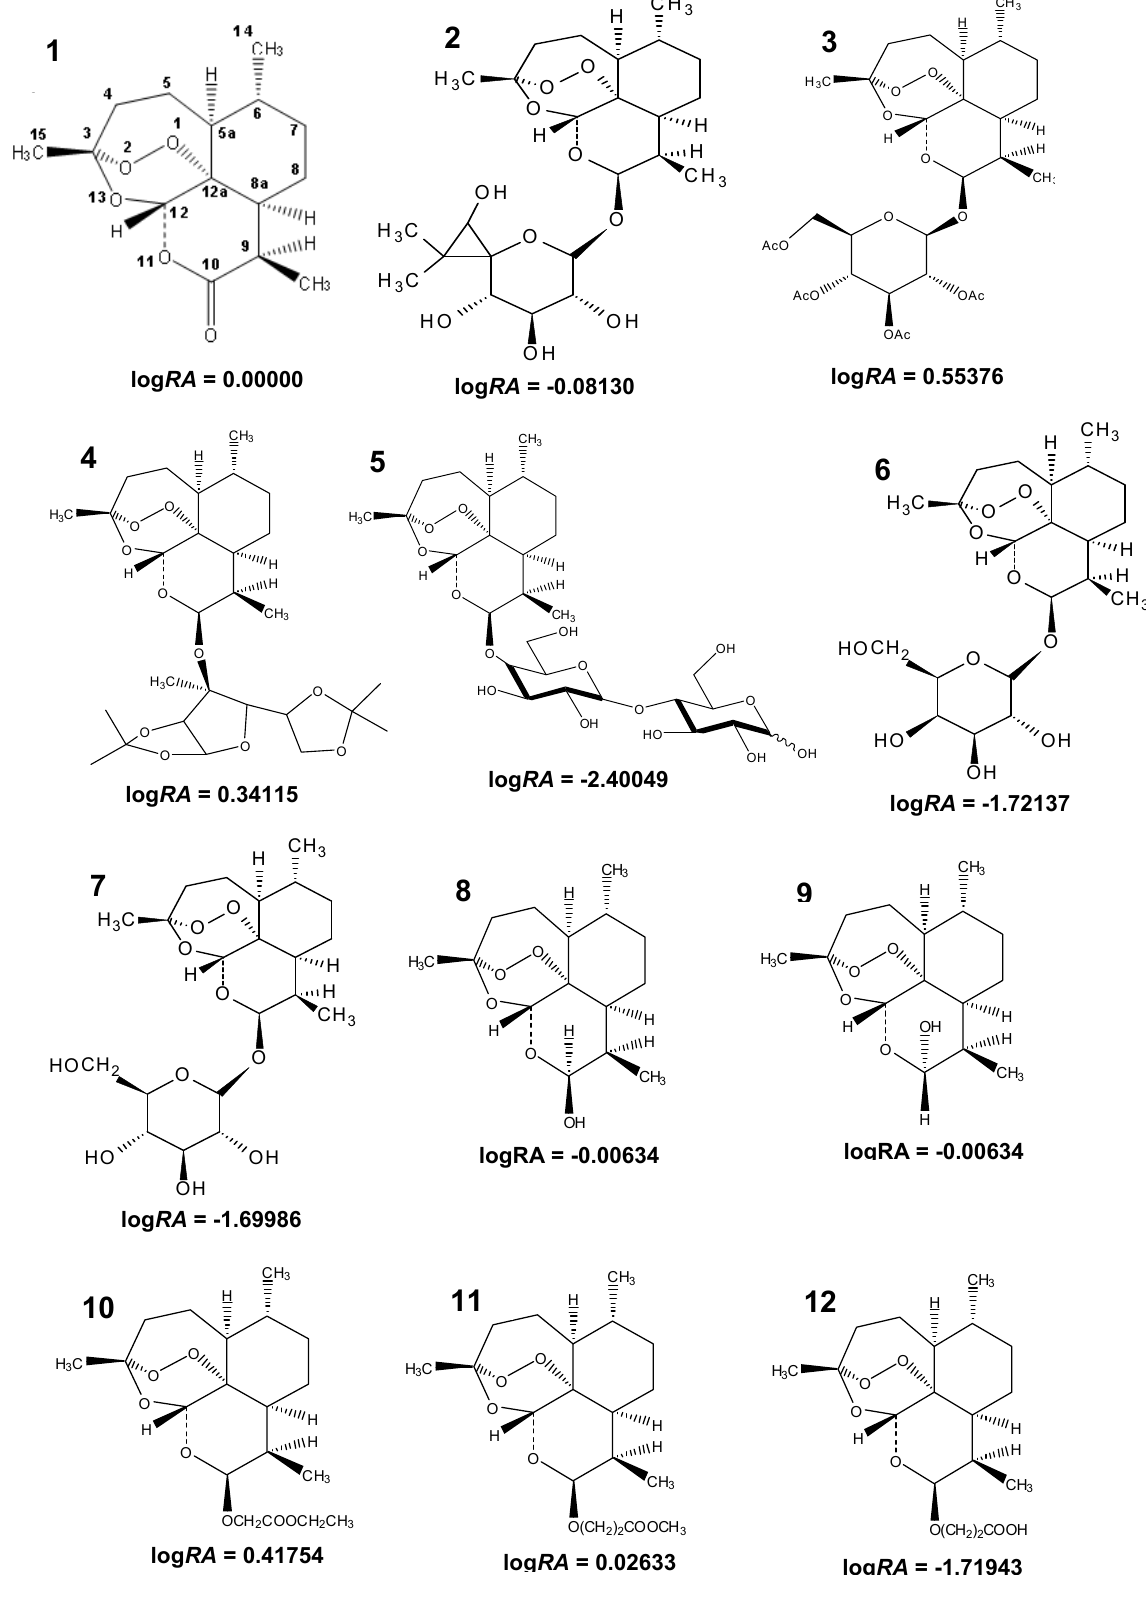
Figure 1. Structure and biological activity of artemisinin